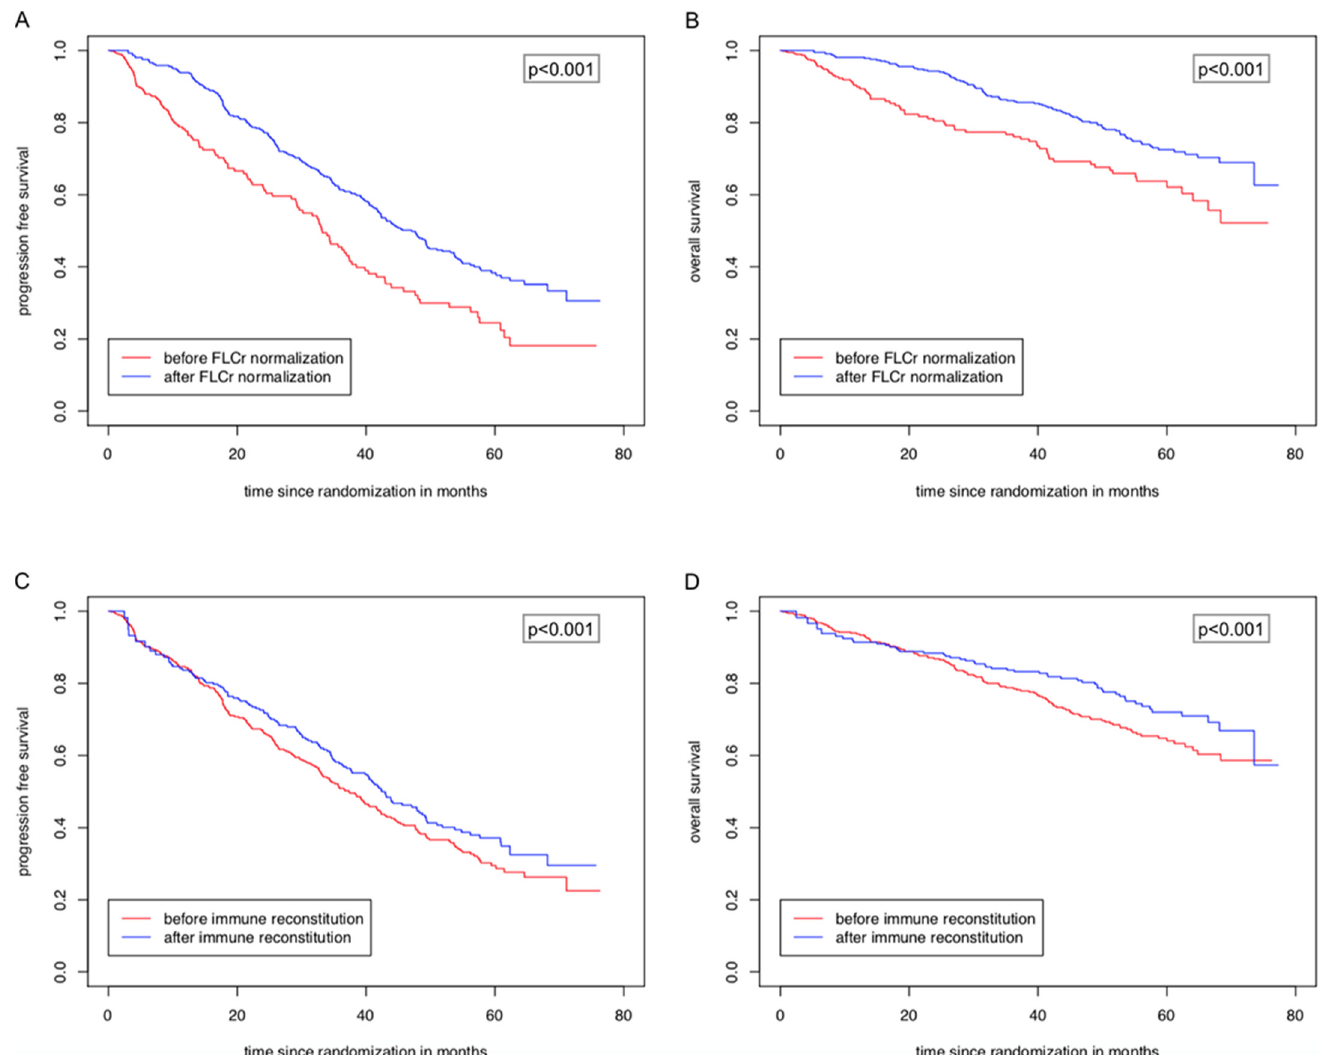
Figure 3. Simon–Makuch Plots showing the risk of progression ( A , C ) and death ( B , D ) depending on the achievement of FLCr normalization and immune reconstitution. The survival times until a potential achievement of FLCr normalization/immune reconstitution and after a potential achievement are separately shown in two curves. Therefore, one patient can be found in two curves. For example, patients with immunoparesis who achieve immune reconstitution during therapy start in the curve “before immune reconstitution” and switch after the achievement of immune reconstitution in the curve “after immune recon- stitution”.